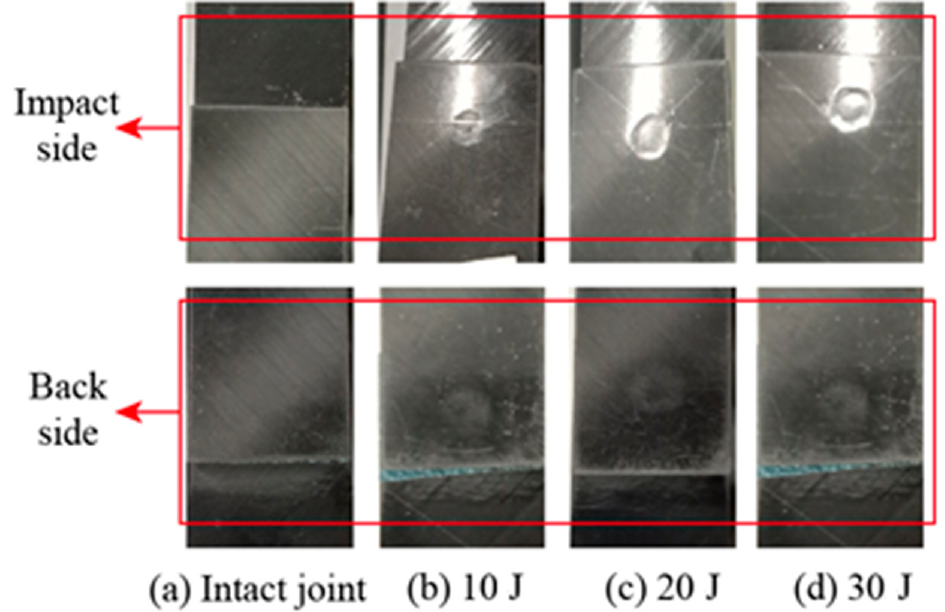
Figure 9. The surface damage of the SLJs under different impact energies: ( a ) Intact joint; ( b ) 10 J; ( c ) 20 J; ( d ) 30 J.